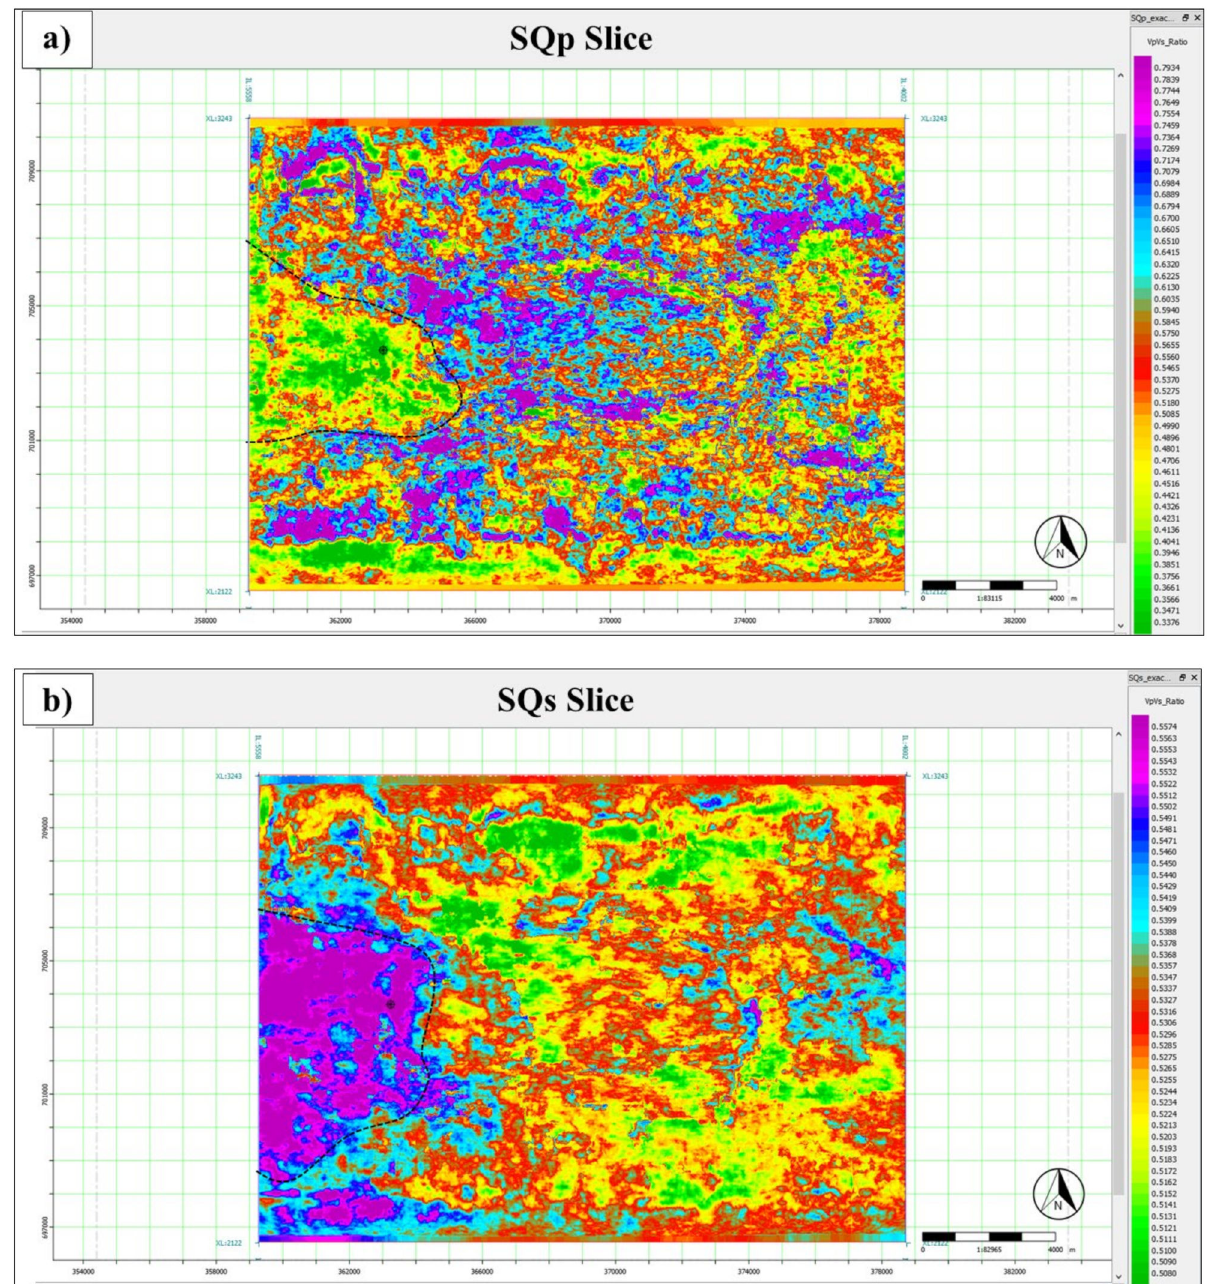
Figure 22. ( a ) Averaged SQp data horizon slice within an interval between Top H and H60 horizons; ( b ) Averaged SQs data horizon slice within an interval between Top H and H60